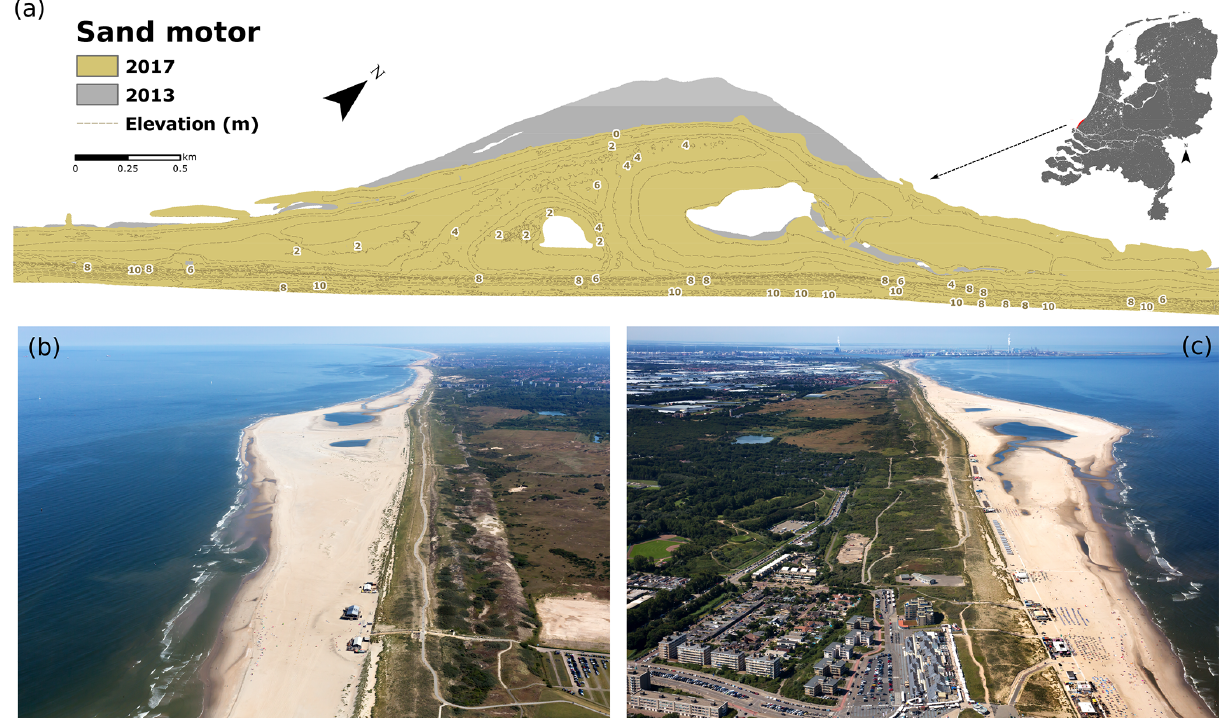
Figure 1. The Zandmotor (“sand motor”), an experimental mega-scale beach nourishment located along the Delfland coast, the Netherlands. (a) The design of the Zandmotor mirrors the onshore migration of an (intertidal) sandbar and aims to provide coastal safety by redistributing its sand along the coastline, thereby broadening the beach and dunes. (b–c) Aerial photographs of the Zandmotor and Delfland coast taken on 9 July 2017, facing north (b) towards The Hague and south (c) towards the harbor of Rotterdam. The Delfland coast maintains relatively wide and natural dune areas, but in some places the dunes are no more than a narrow foredune ridge directly bordered by urbanized areas.